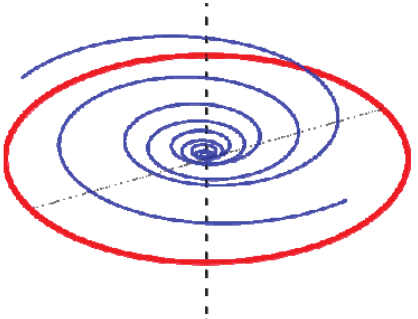
(cid:3) B Figure 9. One field line of reg in the Galactic halo from a model of upward spiraling magnetic field in the Galactic halo [36]. Fig- ure credit: Philippe